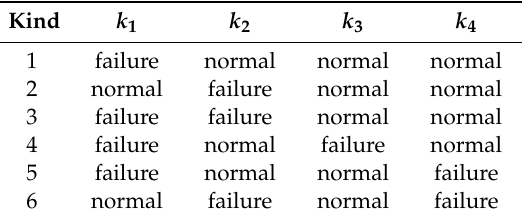
Table 2. Kinds of spring